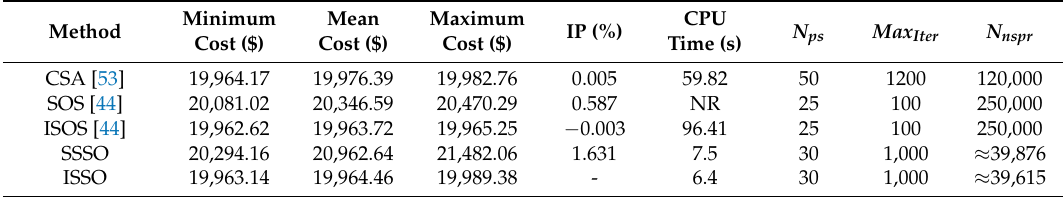
Table 9. Result summary obtained by different methods and the proposed method for system